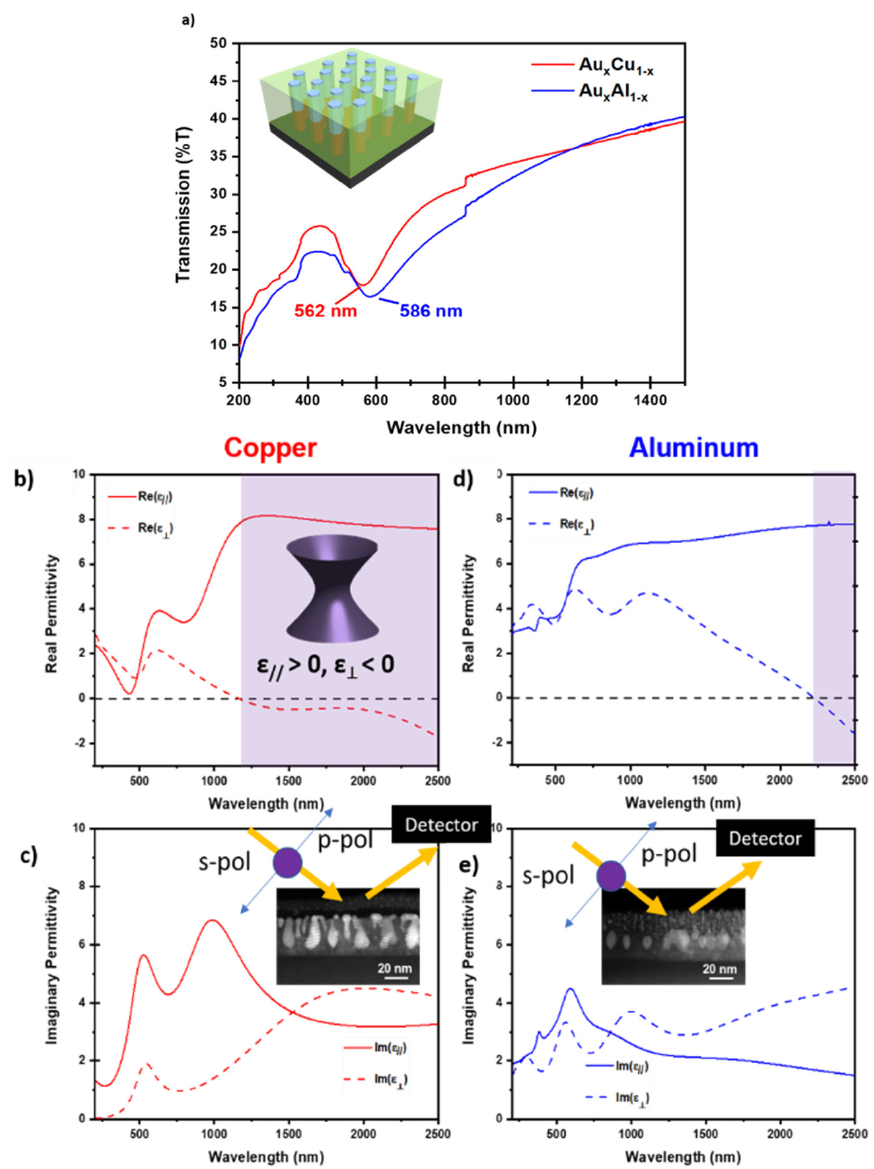
Figure 4. Optical measurements. ( a ) Normal incident depolarized transmittance (T%) of ZnO- Au x Cu 1 − x and ZnO-Al x Au 1 − x . ( b ) Real part of permittivity for ZnO-Au x Cu 1 − x . Highlighted in purple is the location of the hyperbolic regime and the inset diagram represents the isofrequency curve of a. ( c ) Imaginary permittivity for ZnO-Au x Cu 1 − x . Inset is the experimental setup for the ellipsometry measurement for ZnO-Au x Cu 1 − x . ( d ) Real permittivity for ZnO-Au x Al 1 − x . Highlighted in purple is the representative hyperbolic regime. ( e ) Imaginary permittivity for ZnO-Au x Cu 1 − x . Inset is the experimental setup for the ellipsometry measurement with respect to the ZnO-Au x Al 1 − x thin film.